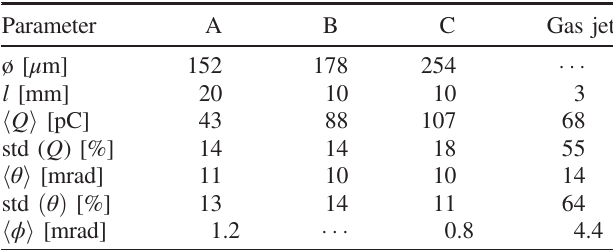
TABLE I. Summary of electron beam stability parameters acquired in three series using capillaries of different diameter (ø) and lengths ( l ) (A – C) in comparison with one series of data acquired using gas jet. The stabilities of the electron beams were studied using the same regime of acceleration. Before acquiring each series of data, the experimental conditions were optimized for best stability, yielding slightly different values of, e.g., backing pressure and laser intensity. The average and standard deviation of charge ( Q ) corresponds to electrons with an energy above 40 MeV measured with the dispersing dipole magnet in the electron beam path. The divergence ( θ ) and the RMS pointing stability ( ϕ ) was measured without the dispersing dipole in the electron beam